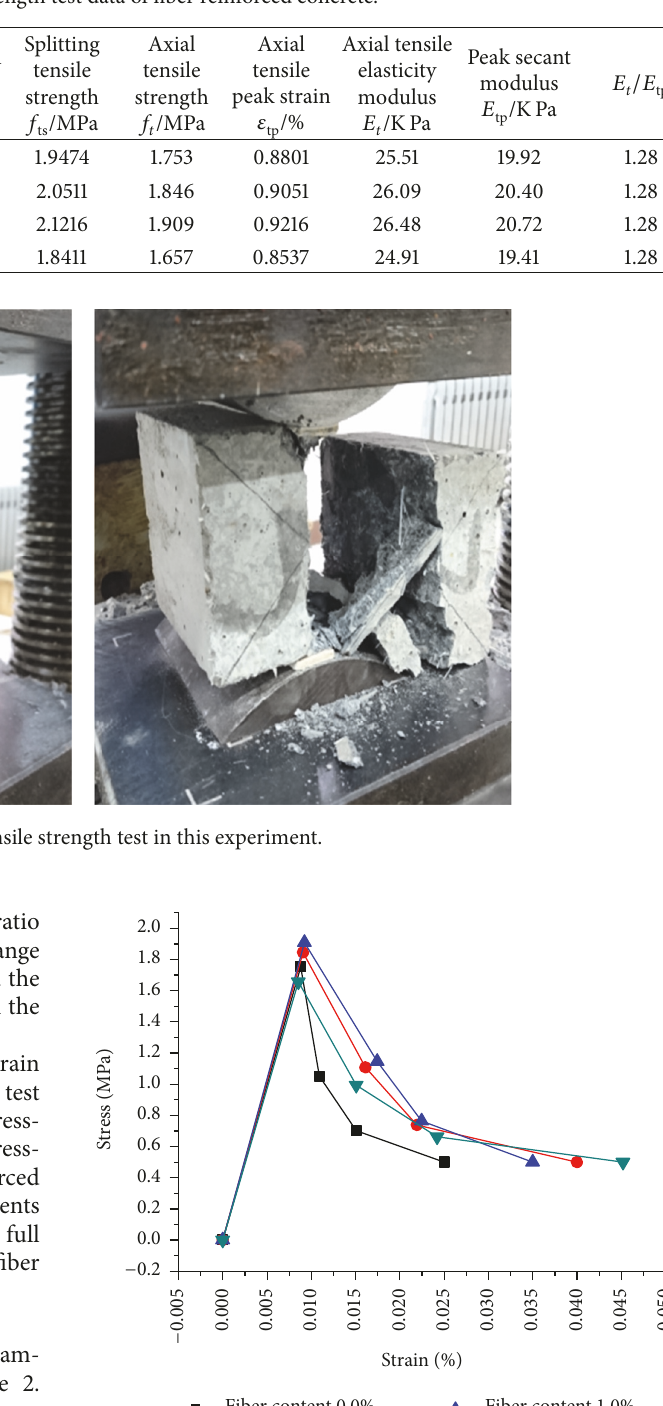
with work stress of 𝜎 = (0.4 ∼ 0.5)𝑓 𝑐 in the structure using stage. The calculation was carried out by taking 0.4 times of the value, that is, 𝐸 𝑐,𝑠 = 𝜎 0.4 /𝜀 0.4 . The